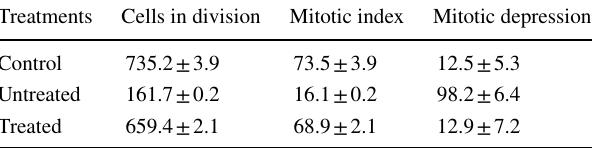
Table 4 Mitotic index and mitotic depression of Allium cepa (onion bulbs) grown in control, untreated and S. wightii -treated BG dye solu- tion 0.05)Treatments Represents mean ± standard deviation with significant difference at P <